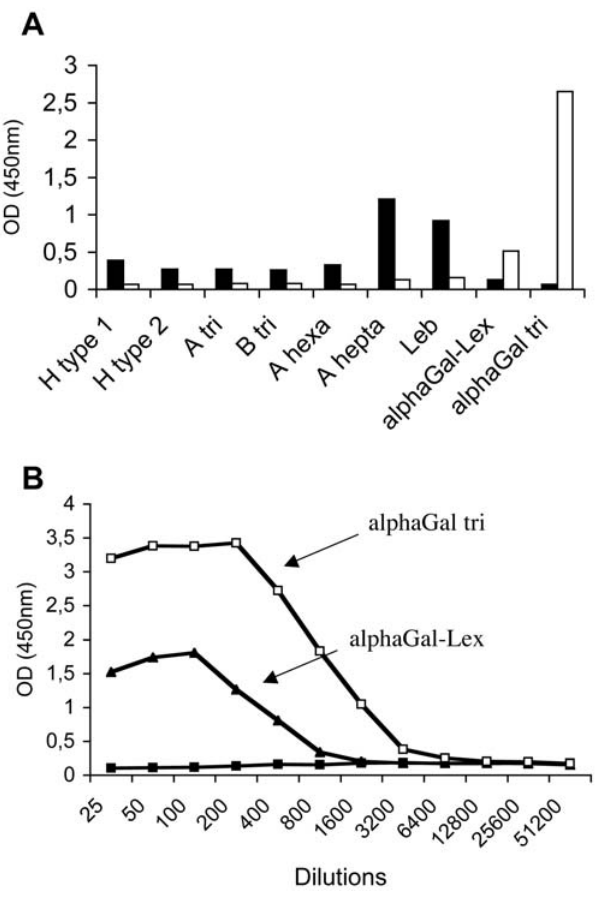
Figure 4. Binding of rNB2 VLPs to immobilized synthetic oligosaccharides. (A) A panel of neoglycoconjugates was coated on ELISA plates at 10 m g/ml and binding of either NB2 (white bars) or NV VLPs (black bars) was detected as described in the Materials and Methods section. OD 450 nm values on selected glycoconjugates are shown. No positive values were recorded for any of the other glycoconjugates listed in Table 1. (B) Binding of rNB2 VLPs to serially diluted structurally related PAA-conjugates. White squares: a Gal trisaccharide ; black triangles: a Gal-Lex ; black squares: mean of other PAA-conjugates (see Table 1 for structures). Results are shown as OD 450 nm as a function of the reciprocal of PAA-conjugate dilutions with 1/25 corresponding to 40 m g/ml.